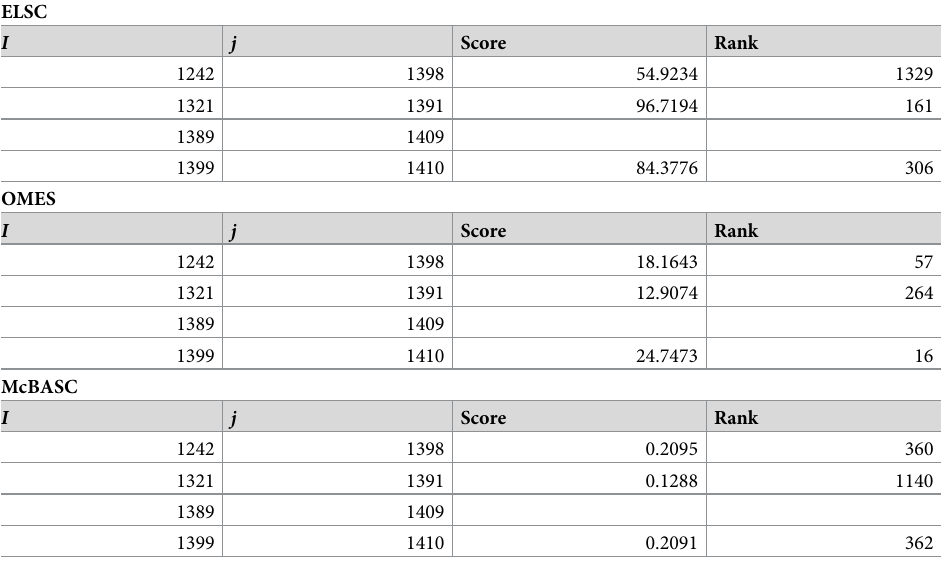
Table 6. 1235 Subset coupled residues in agreement with Gulya´s-Kov à cs study[19].